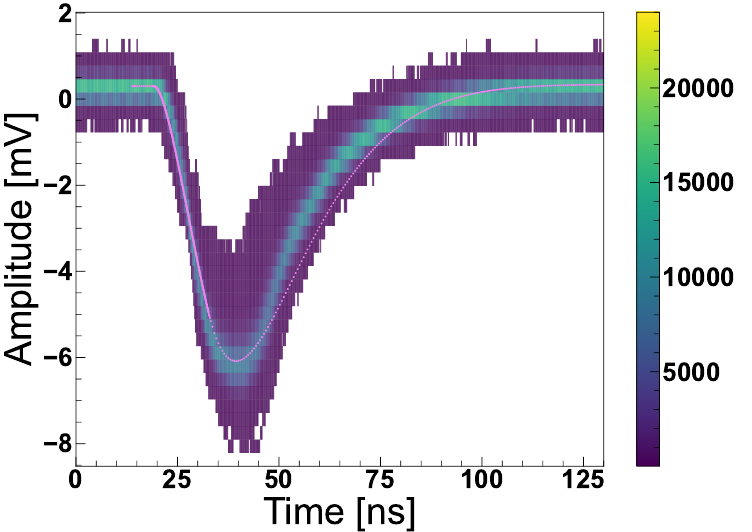
Figure 8. Two-dimensional density histogram of recorded signals for the high-gain channel on the first layer of AGILE. The simulated signal is plotted as a dotted violet